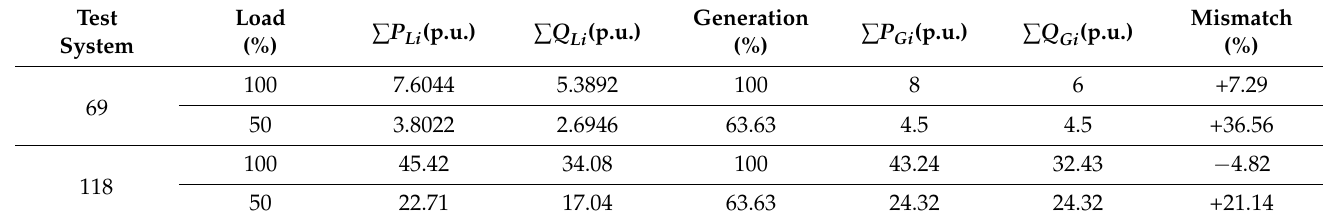
Table 3. Test system generation to load states for 69- and 118-bus systems.